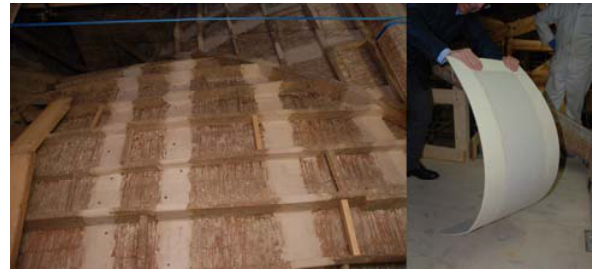
Figure 8: consolidation of the vault with